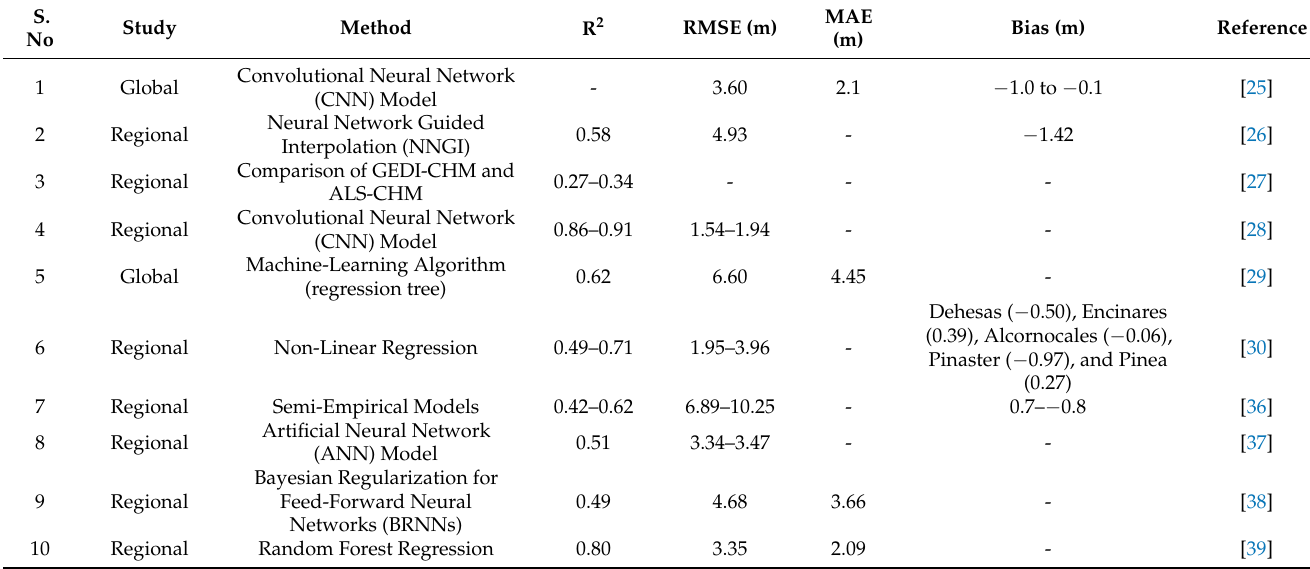
Table 1. Past studies on the canopy height estimation studies using the GEDI LiDAR